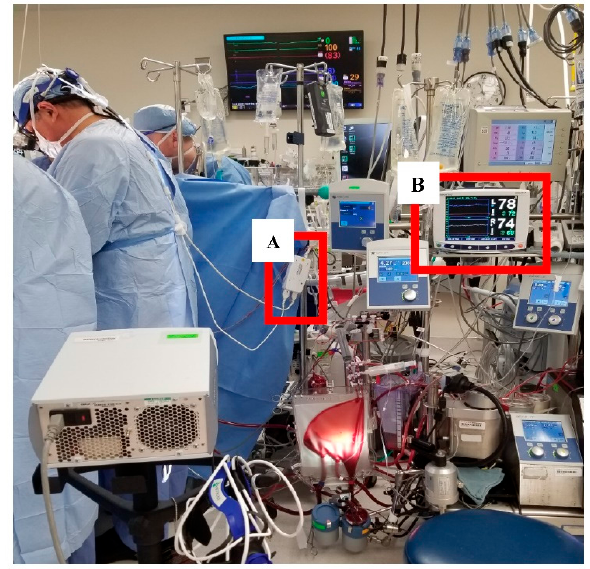
Figure 2. NIRS acquisition device placement in relation to the attending surgeon and cardiopulmonary bypass pump. A. highlights the preamplifier and B. highlights the INVOS™ monitor receiving data from the sensors.